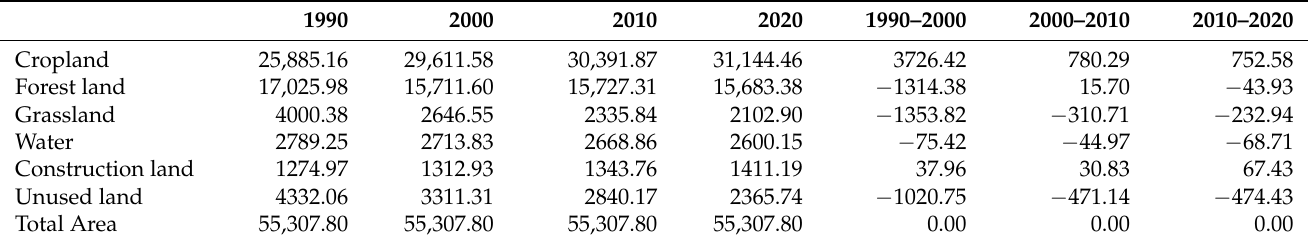
Table 3. The first-class land use area in 1990, 2000, 2020 and their dynamic changes with 10-year intervals from 1990 to 2020 in the southern region of Sanjiang Plain (unit: km 2